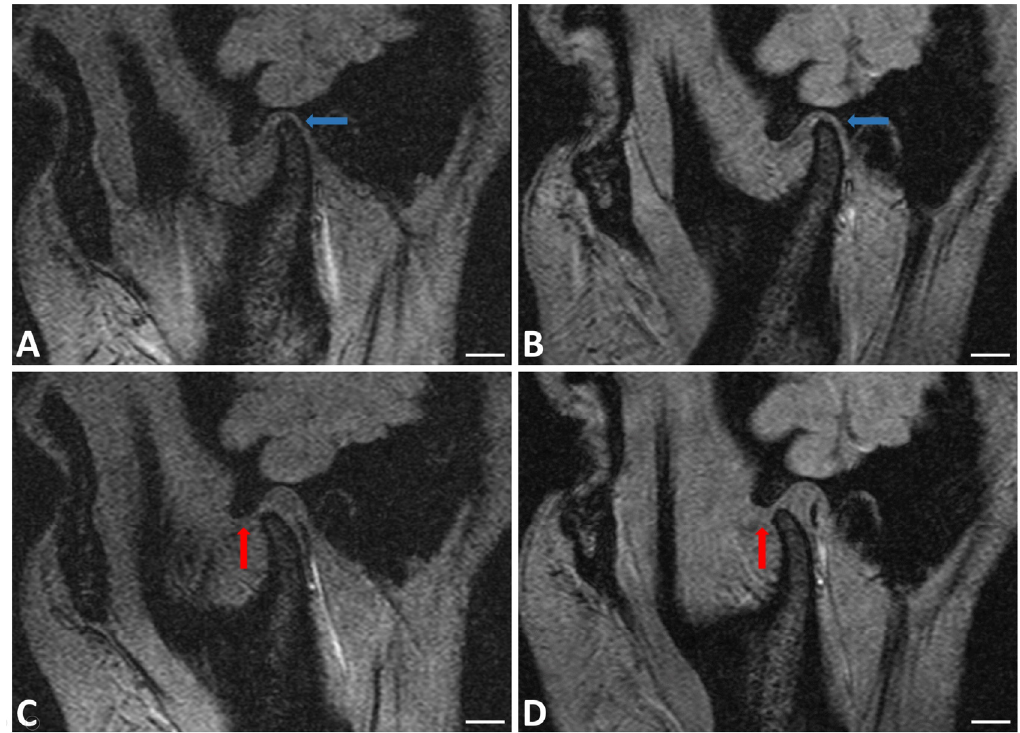
Figure 2. Right TMJ MRI in sagittal plane of patient with the jaw closed at T0 ( A ) and T1 ( B ) and open at T0 ( C ) and T1 ( D ). Increased disk and cartilage thickness (blue arrows) and increased excursion of mandibular condyle (red arrows) were observed. BAR = 1 cm